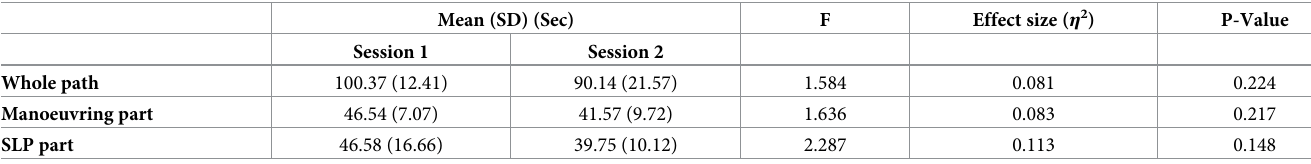
Single-value parameters The results of single-value parameters of eleven subjects are presented in this part. After check- ing for compliance with normal distribution, 15 out of 37 variables (38%) were shown to need variable transformation, which was done using the Two-Step method [21]. The results of each group of single-value parameters are presented under the respective headings. Group I: Time. The statistical details of results for the time taken for subjects to finish the whole IAT path and the SLP and manoeuvring part of it are presented in Table 3. The significance of Box’s test of equality of covariance matrices for these variables was obtained as 0.307 and this does not provide enough evidence to reject the null hypothesis of Box’s test which says the covariance of matrices are equal, so this MANOVA assumption is also met. Df2 for this group of parameters was 19. The significance of MANOVA results was 0.441 (Pillai’s Trace method) which cannot reject the null hypothesis that says the time taken for the subjects to finish different parts of IAT is statistically the same at the two sessions (similarity was not rejected- favorable for our study). Table 3. Detailed statistical results for the time taken to finish different tasks.